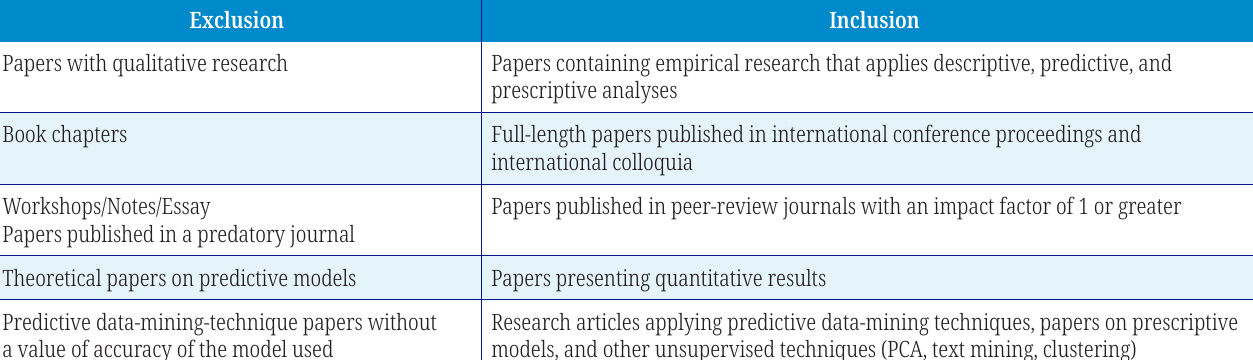
Table 1. Criteria for including and excluding